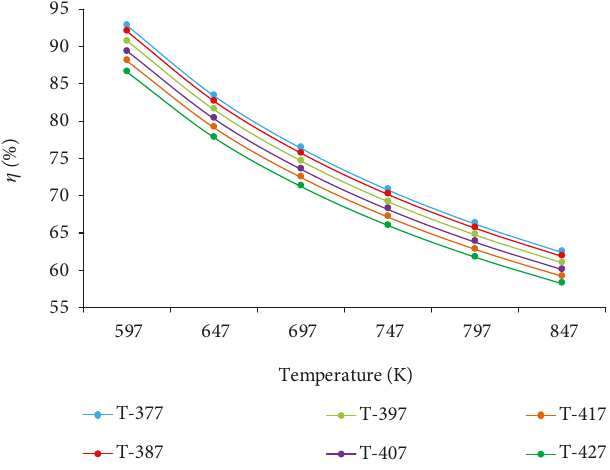
Figure 18: E ff ect of inlet temperature of HTF on heat storage e ffi ciency.